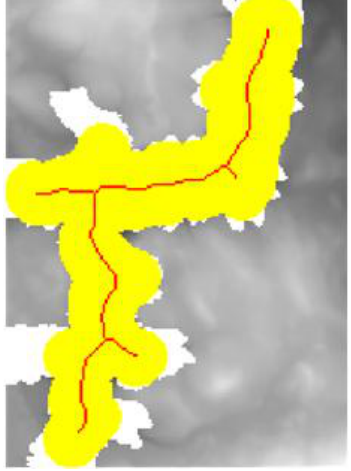
Figure 6. Smoothing of regions composed of identified cross-sections – white areas represent parts of the region excluded by smoothing, the yellow area is the result of smoothing and the red line is the skeleton line used for the length assessment.